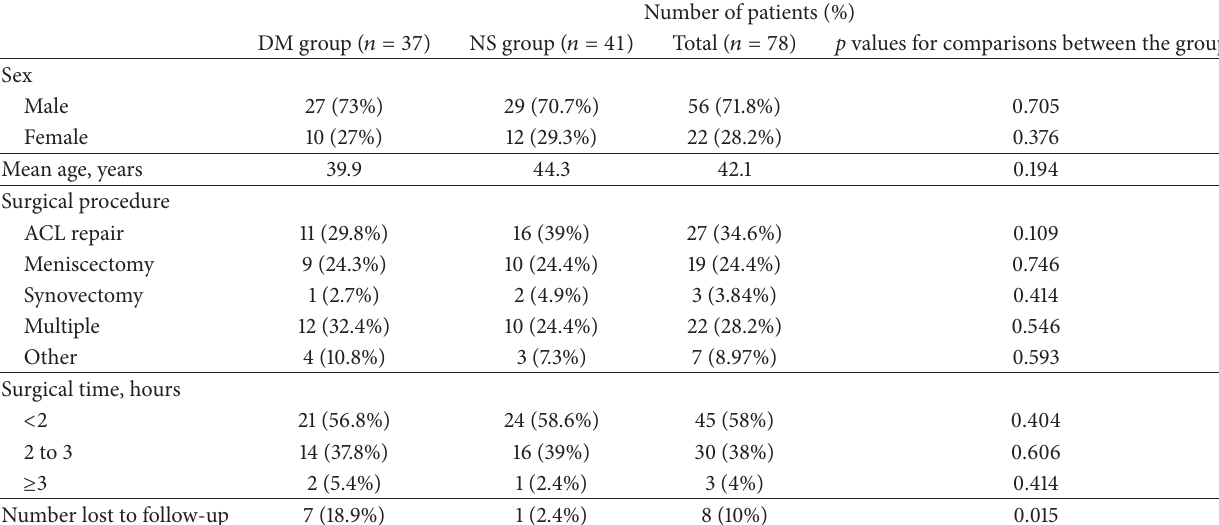
Table 1: Patient characteristics.